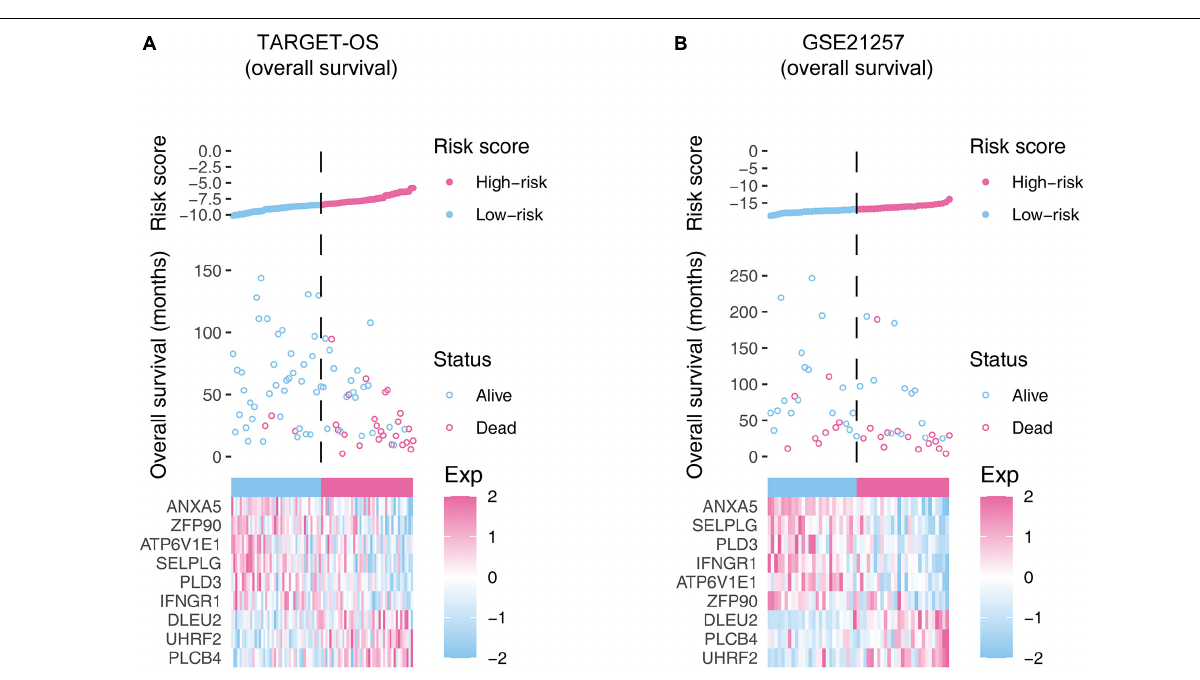
FIGURE 4 | The overall distributions of the risk score (upper), survival status (middle), and gene expression profiles (bottom) of the nine-gene signature in the training (A) and validation (B) cohorts.The top parts show the distributions of the risk score. The center parts show the distributions of the patient survival time and status. The bottom parts indicate heatmaps of the nine gene expression